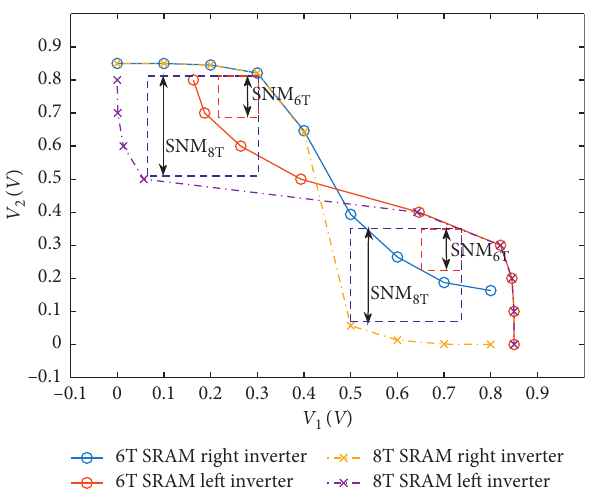
Figure 8: Butterfly curve of GNRFET-based 6T and 8T SRAM cells in the access mode.